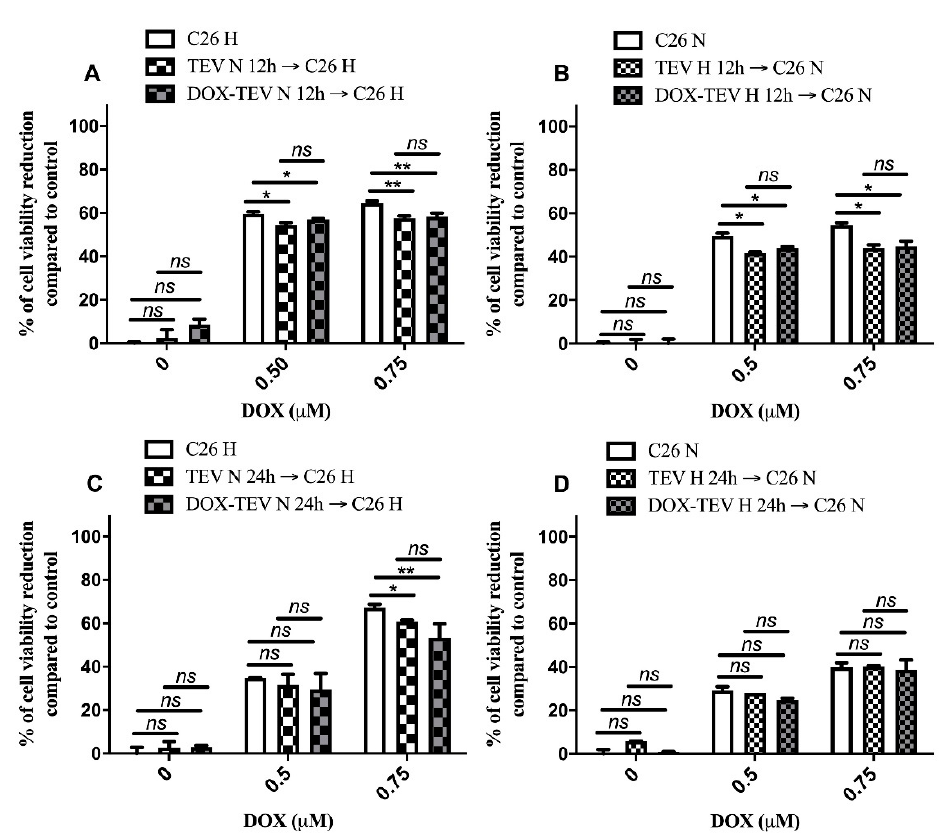
Figure 4. C26 cell viability reduction under normoxia and hypoxia after pretreatment with EVs from C26 cells and exposure to DOX treatment. The e ff ects of TEV secreted by untreated normoxic C26 cells (TEV N) or by 0.3 µ M DOX-treated normoxic cells (DOX-TEV N) on hypoxic C26 cells (C26 H) treated with di ff erent DOX concentrations for 12 h are shown in panel ( A ) and for 24 h are shown in panel ( C ). The e ff ects of TEV secreted by untreated hypoxic C26 cells (TEV H) or by 0.3 µ M DOX-treated hypoxic cells (DOX-TEV H) on normoxic C26 cells (C26 N) treated with di ff erent DOX concentrations for 12 h are shown in panel ( B ) and for 24 h are shown in panel ( D ). Data from interexperimental duplicates are represented as mean ± SD and expressed as a percentage compared to the corresponding controls (untreated C26 cells, C26 cells treated with 0.5 µ M DOX that were not pretreated with TEV, and C26 cells treated with 0.75 µ M DOX that were not pretreated with TEV, respectively); ns : not significant, p > 0.05; *, p < 0.05; **, p < 0.01.